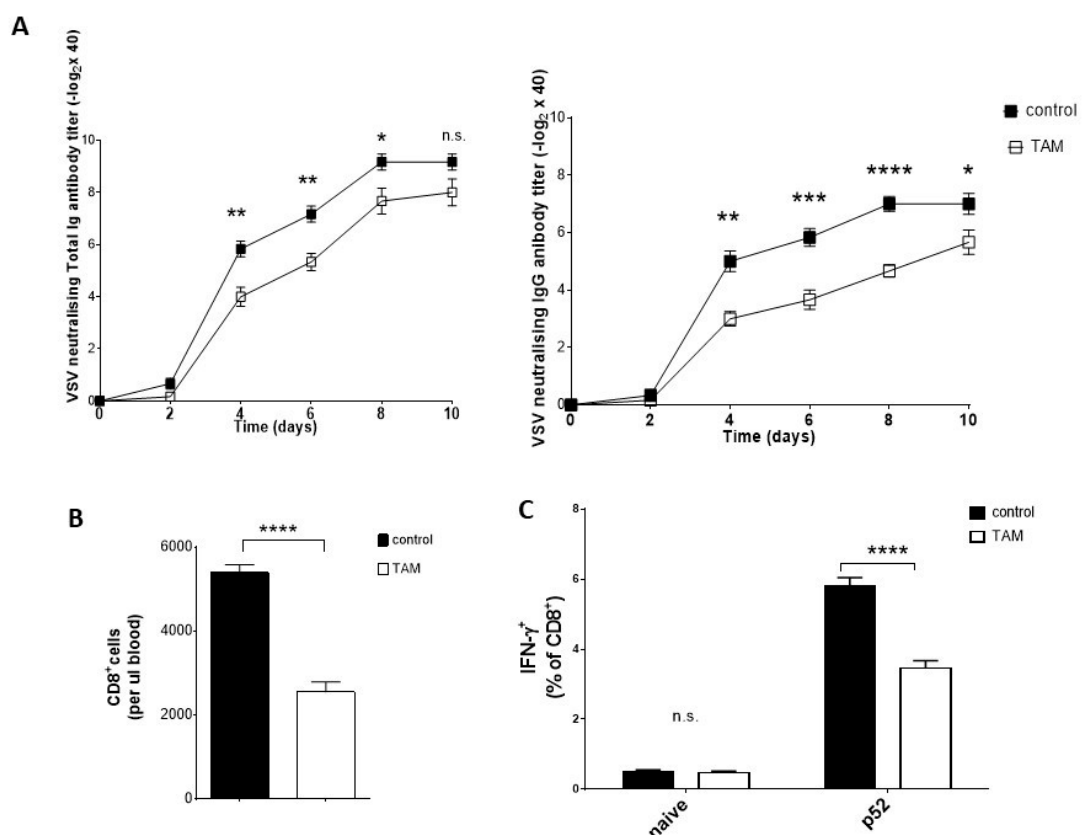
Figure 3. TAM suppresses the VSV neutralizing antibody response. ( A ) VSV neutralizing antibodies were measured in sera harvested from TAM pretreated C57BL / 6 mice (4 mg TAM i.p. per mouse, applied at day -3 and -1) and control mice (treated with corm oil) at the indicated time points after infection with 2 × 10 4 PFU VSV ( n = 6). The left graph shows the total amount of VSV neutralising antibodies measured without pretreatment with β -mercaptoethanol. The right graph shows the titer of VSV neutralising IgG antibodies in serum that was pretreated with β -mercaptoethanol to remove IgM and IgA antibodies. ( B ) Total amount of CD8 + T cells was analyzed in blood of TAM-pretreated and control mice 10 days after VSV infection by flow cytometry ( n = 6). ( C ) Percentage of CD8 + T cells from spleen capable to produce INF- γ after restimulation with virus-specific peptide p52 was measured in TAM pretreated and control mice 10 days after VSV infection by flow cytometry ( n = 6). Data are expressed as means ± SEM. n.s.: not significant, * p = 0.05; ** p = 0.01; *** p = 0.001; **** p < 0.001.